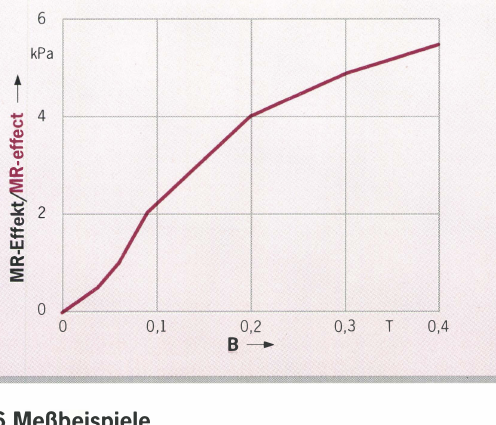
t(B)-t(O) as a function of B for the same MRF. The MR effect, i.e., the difference between the shear stress with and without an applied magnetic field,